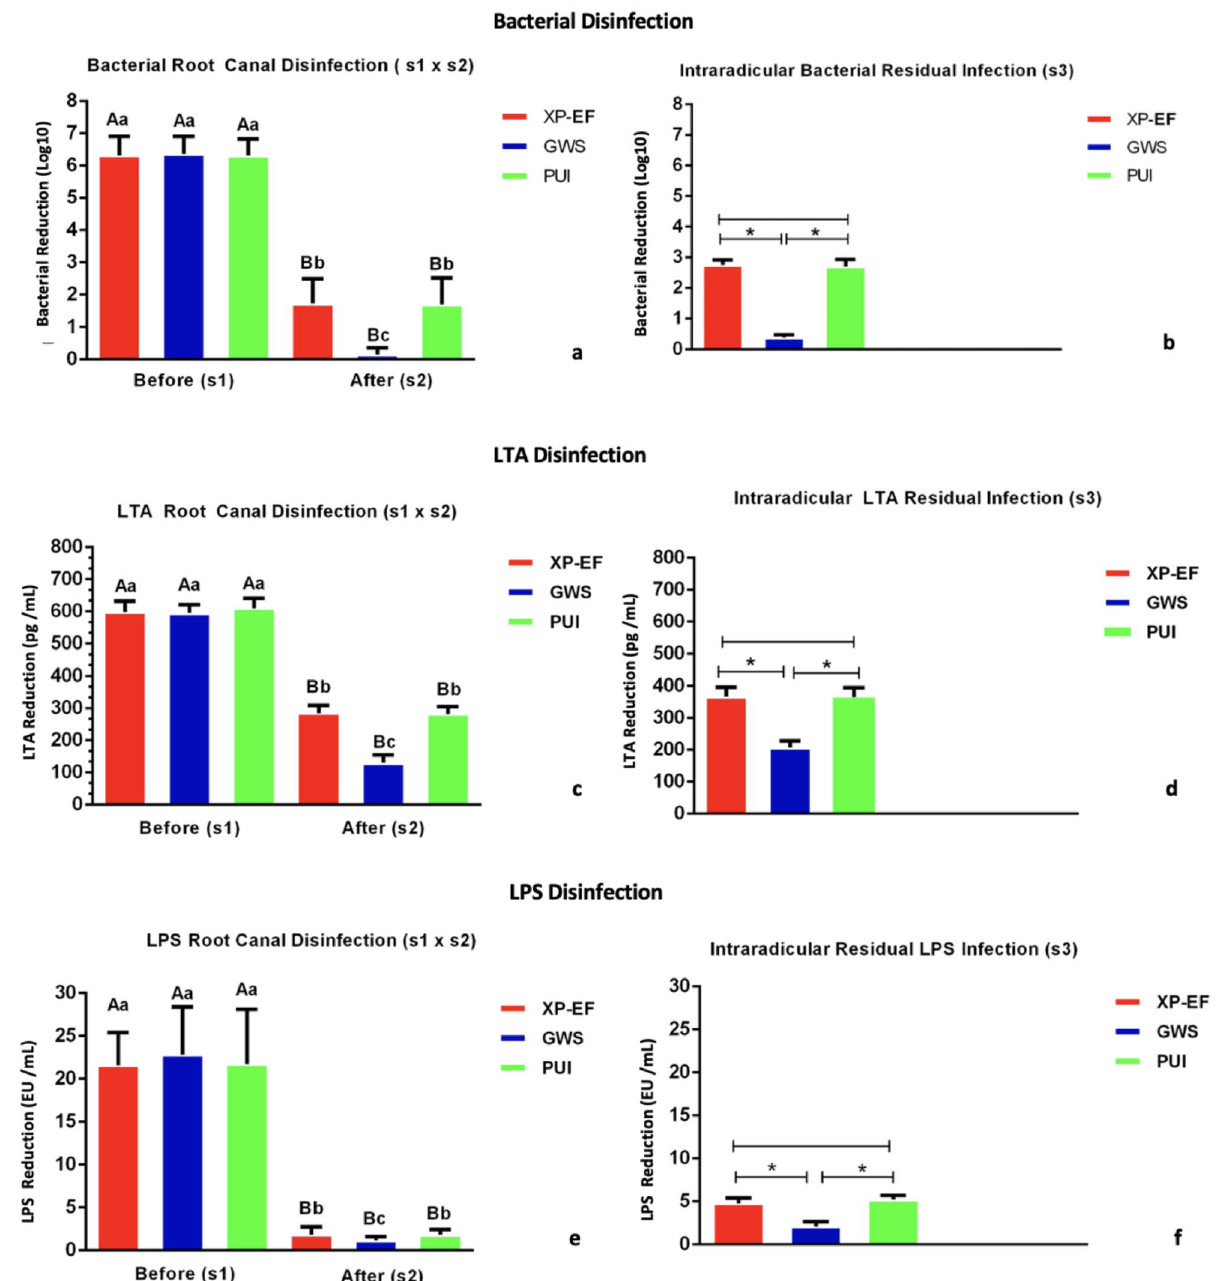
Figure 1. Bacterial disinfection (Log10)—( a ) mean bacterial count recovered from the root canals before (S1) and after (s2) root canal disinfection protocols using paper point sampling. ( b ) mean intraradicular residual bacterial infection after cryogenic grinding technique (s3). Lipoteichoic acid (LTA) disinfection (pg/mL)—( c ) mean LTA levels detected in the root canals before (S1) and after (s2) disinfection protocols using paper point sampling technique. ( d ) mean intradicular residual LTA infection after cryogenic grinding technique (s3). Lipopolysaccharide (LPS) disinfection (EU/mL)—( e ) mean LPS levels detected in the root canals before (S1) and after (s2) disinfection protocols using paper point sampling technique; ( f ) mean intradicular residual LTA infection after cryogenic grinding technique (s3). Different uppercase letters indicate statistically significant intragroup difference. Different lowercase letters indicate statistically significant intergroup difference. Symbol (*) indicates significant difference (p < 0.05). XP-EF, XP-Endo Finisher; GWS, GentleWave System; PUI, Passive Ultrasonic